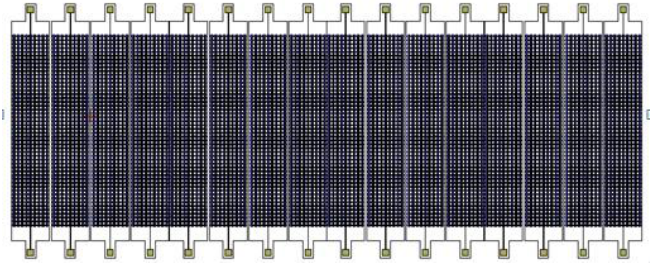
Figure 2. The resultant 1 × 16 CMUT array structure.